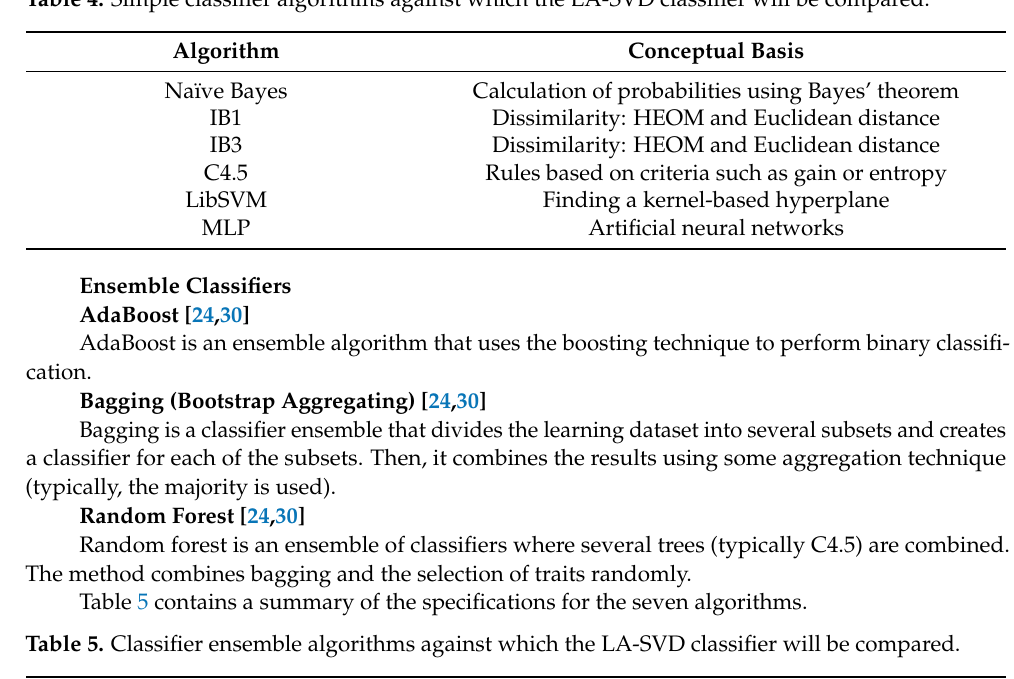
Table 4. Simple classifier algorithms against which the LA-SVD classifier will be compared.